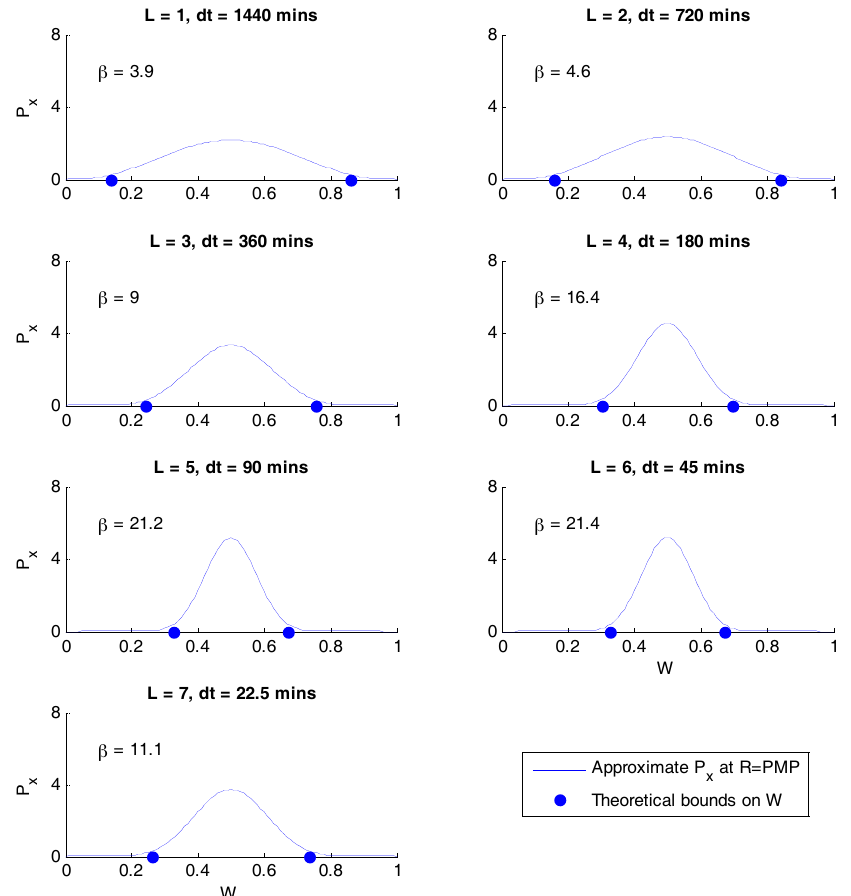
Figure 3. Beta distribution functions used to represent the theoretical bounds on W at R = PMP .